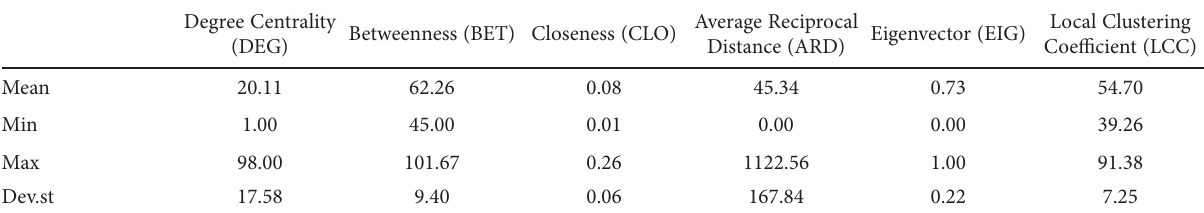
Table 3. Statistics of the network independent variables.